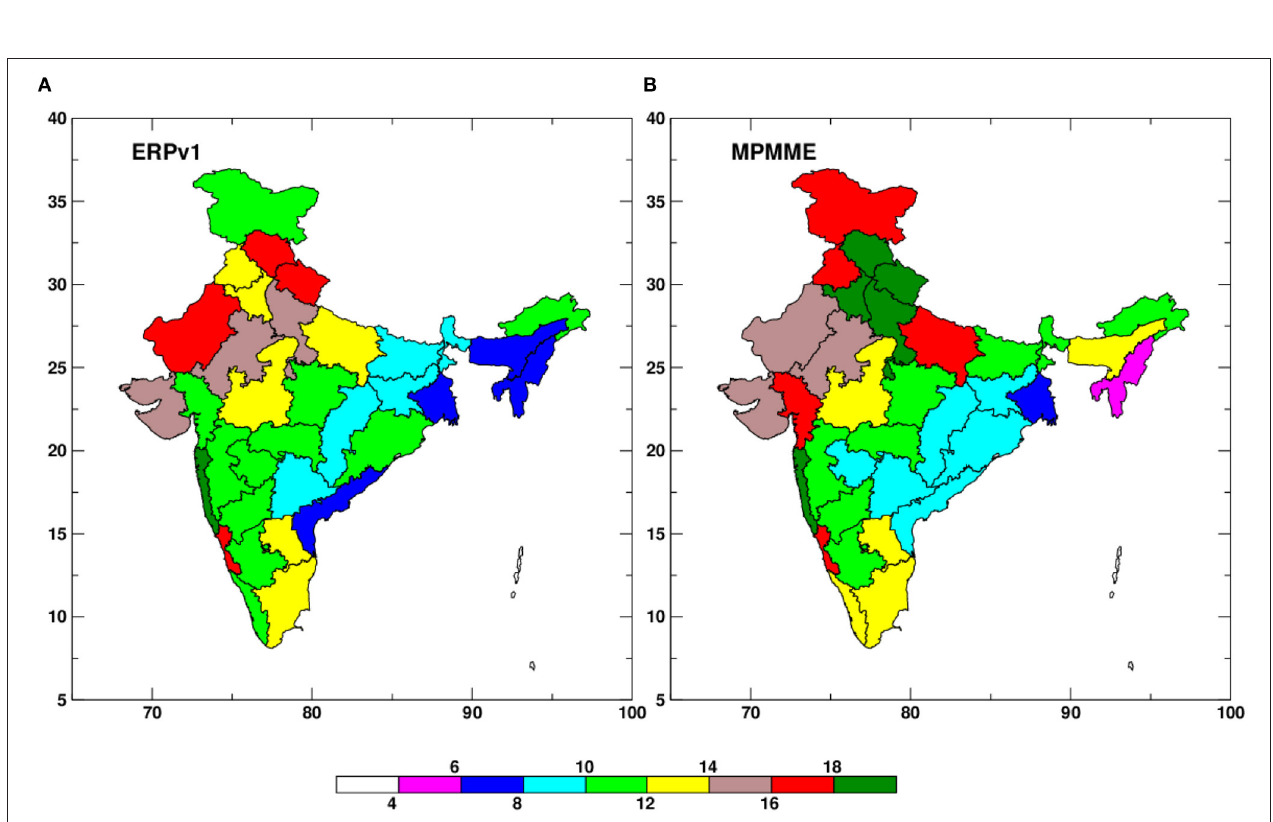
FIGURE 4 | Subdivision-wise predictability limit for (A) extended range prediction system (ERPv1) and (B) multi-physics multi-model ensemble (MPMME) during monsoon.